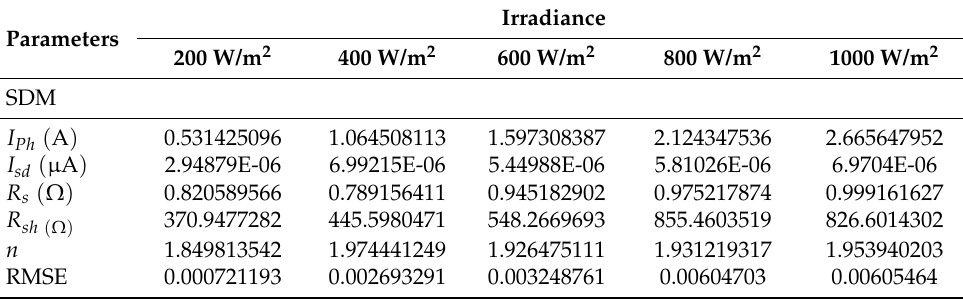
Table 16. Optimal parameters with various irradiance under 25 °C on